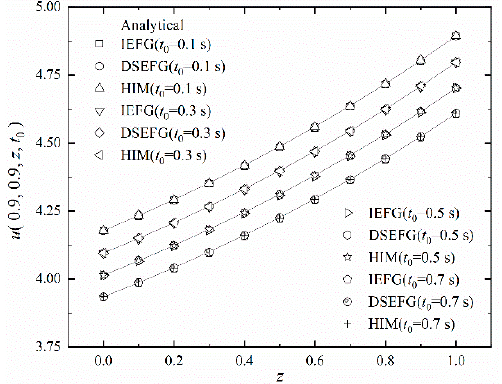
Figure 11. Calculation results along z -axis when t 0 is